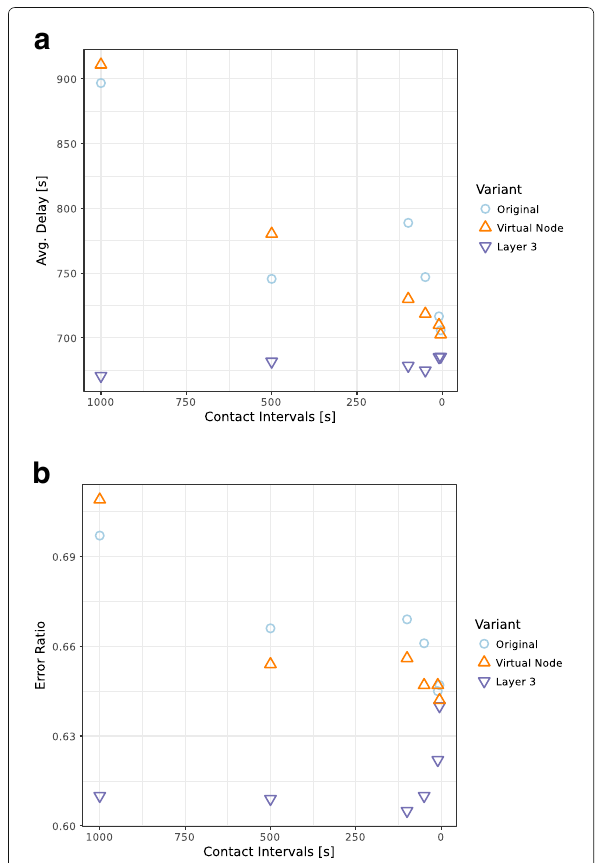
Fig. 7 Performance resulting from different variants. a Delay b Error ratio